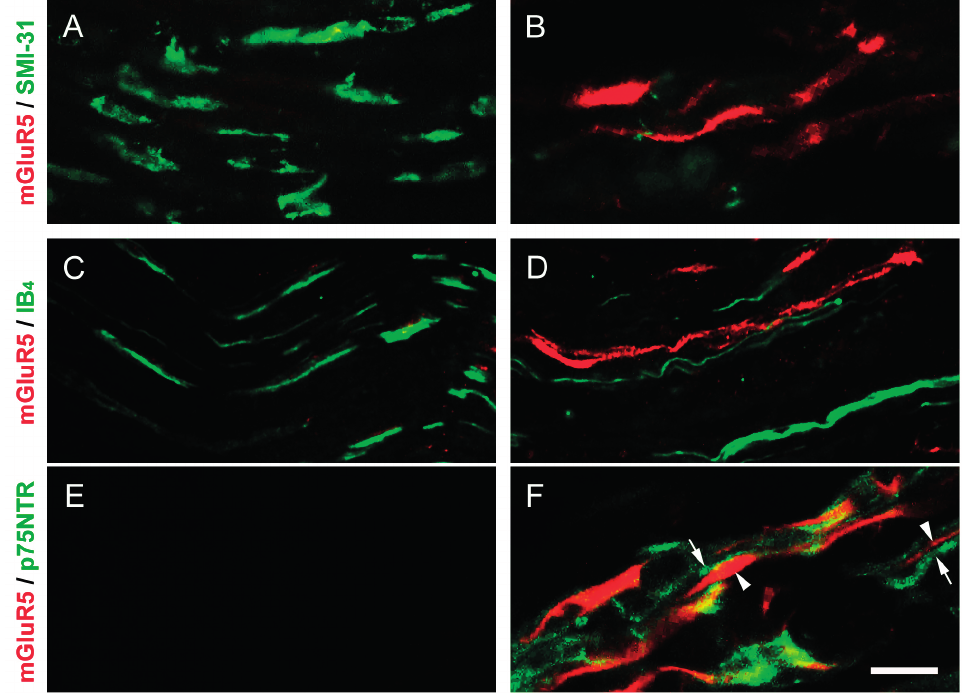
Figure 7. Double-labeled immunofluorescence along the distal CCI stumps of sciatic nerve. The mGluR5-IR fibers (red) at POW 2 in the ipsilateral sides of sciatic nerve were illustrated after ( A , C , E ) sham-operated surgery and ( B , D , F ) CCI. These merged images showed the intact fibers combined with antibody against ( A , B ) phosphorylated neurofilament (SMI-31) and ( C , D ) Griffonia (Brandeiraea) simplicifolia isolectin B4 (IB4) (green). Moreover, the localization of reactive Schwann cells was demonstrated with antibody against ( E , F ) p75 neurotrophin receptor (p75NTR) (green). p75NTR-IR reactive Schwann cells (arrows, in F ) exhibited the irregular flattened appearance surrounding the mGluR5-IR fibers (arrowheads, in F ). Scale bar = 25 μ